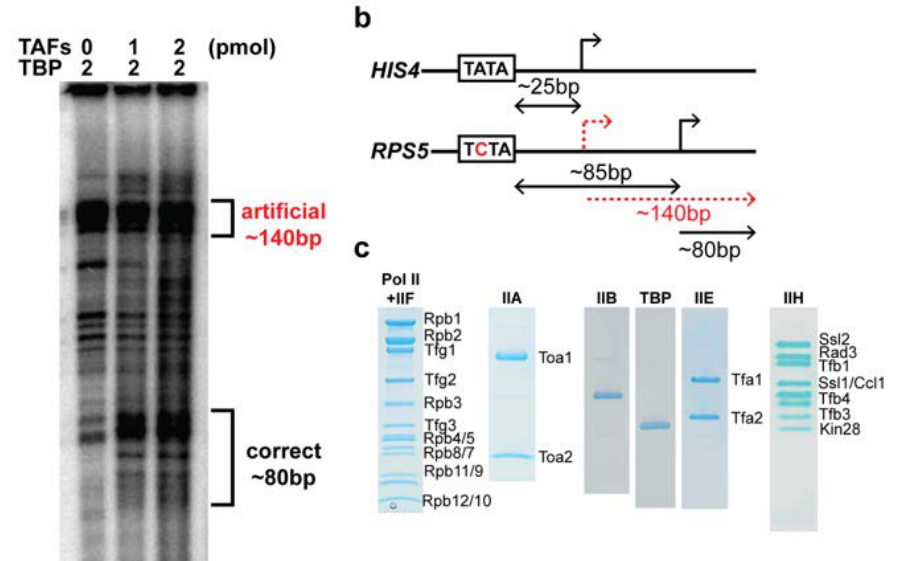
Figure 3. Reconstitution of transcription from the housekeeping RPS5 gene. ( a ) Run-o ff transcription gel. ( b ) Schematic representation of the TATA-containing HIS4 and the TATA-less RPS5 promoters. The artificial TSS due to TBP-dependent not TAF-dependent transcription is indicated with a dashed red arrow. The length of the artificial and correct transcripts on the RPS5 promoter are indicated with a red dashed and black arrow below the RPS5 promoter schematic picture. ( c ) Purification of general transcription factors (GTFs). SDS–PAGE of the remaining purified GTFs with the individual subunits indicated for multi-subunit